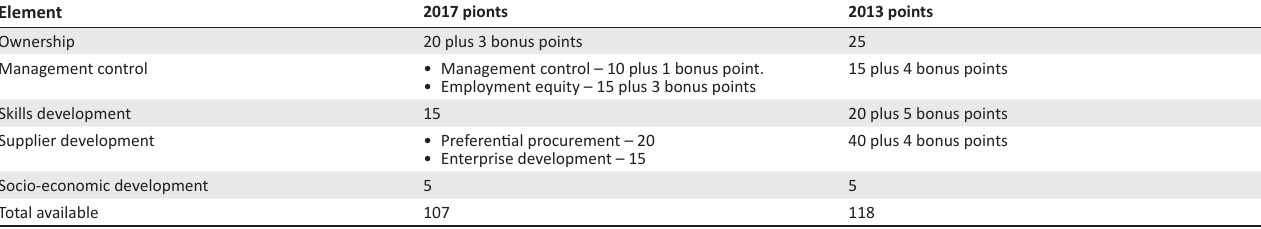
TABLE 2: Comparison of the 2007 and 2013 Codes (points allocated per element). Element